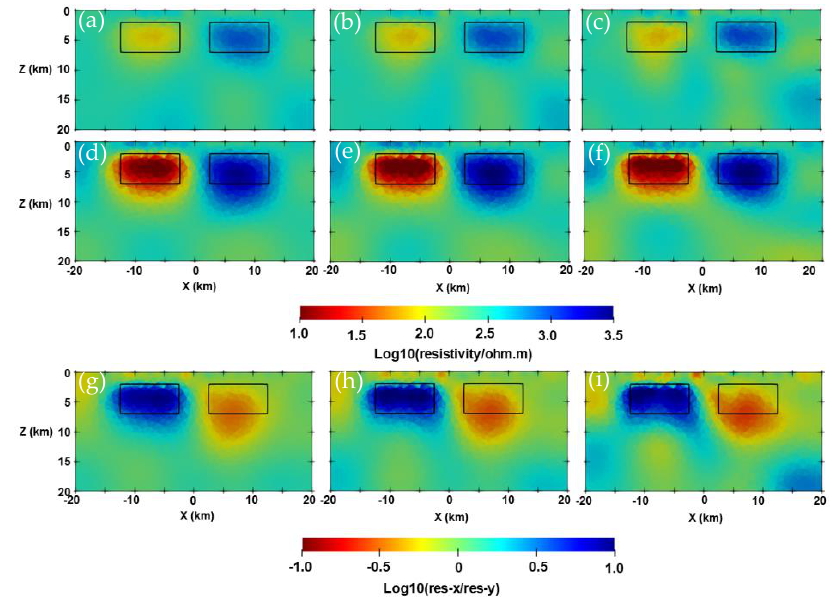
Figure A5. Anisotropic inversion results at y = 0 km for different 𝑐 , and 𝑞 𝑖 = 0.6 . Panels ( a ) – ( c ) show the inverted resistivity in the principal X direction for 𝑐 = 1,2,3 . Panels ( d ) – ( f ) show the inverted resistivity in the principal Y direction for 𝑐 = 1,2,3 . Panels ( g ) – ( i ) show the inverted anisotropic coefficient for 𝑐 = 1,2,3 .